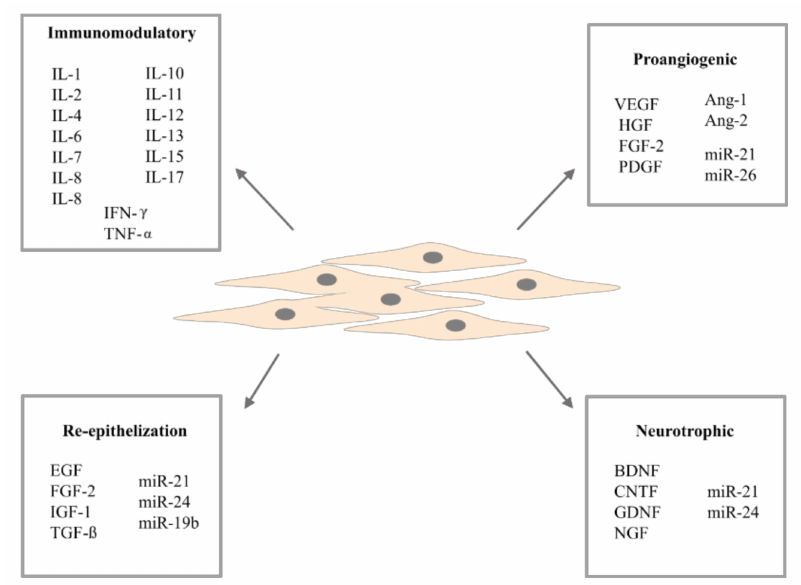
Figure 1. Different types of secretory activity of adipose-derived stem